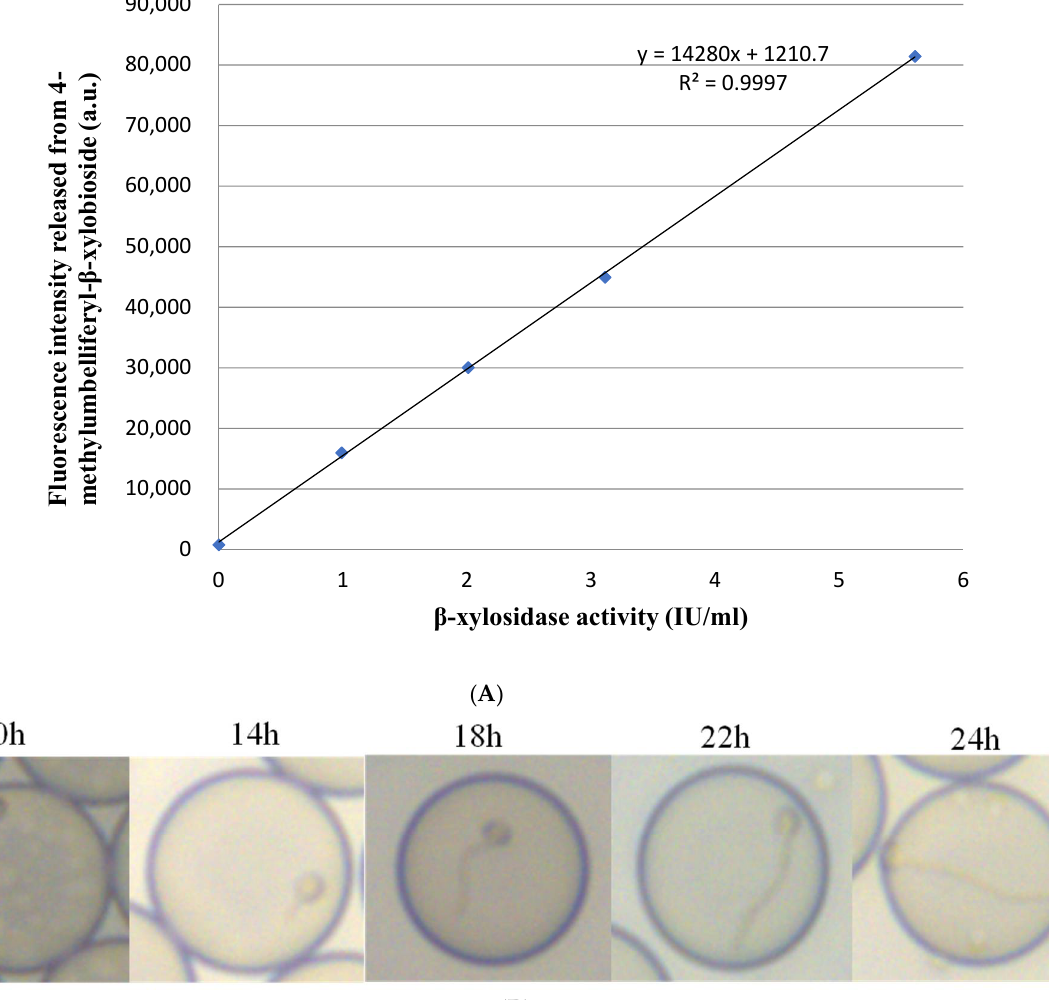
Figure 1. ( A ) Positive linear relationship between fluorescence intensity released from 4- methylumbelliferyl-β-xylobioside and β-xylosidase activity. ( B ) Fungal hyphal growth and fluores- cence signal detection in droplets at different cultivation times (scale bar = 50 μm).